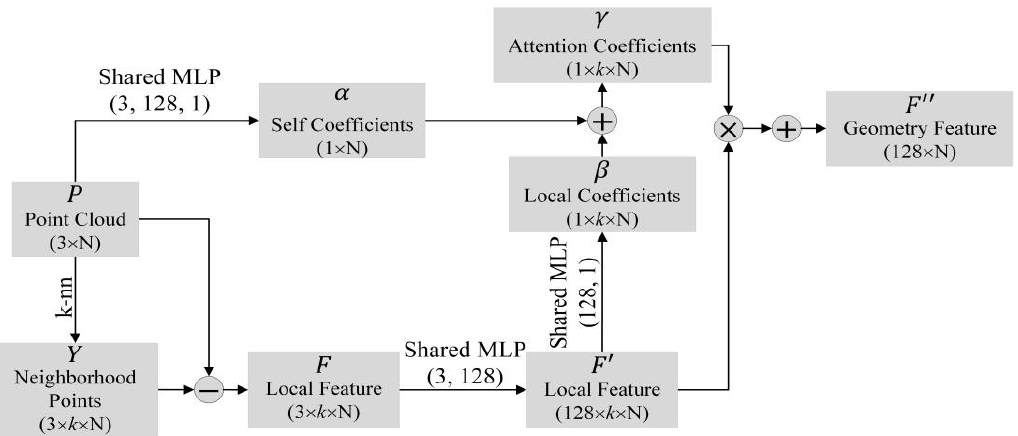
Figure 4. Structure of the Graph Conv Layer, where k is the number of the selected neighborhood points. MLP is the multi-layer perceptron, and the numbers in parentheses indicate the dimensions of the layers.